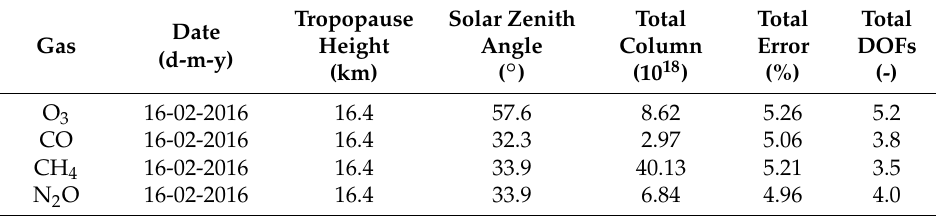
Table 1. Description of the spectra selected for the case